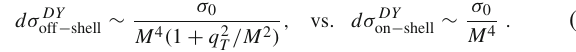
By the comparison with the cross section (47), we see that (56) has different mass